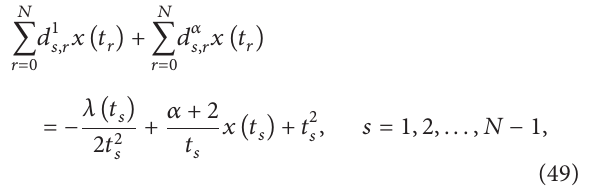
Table 1: Maximum errors in the state x and in the control u for different values of N